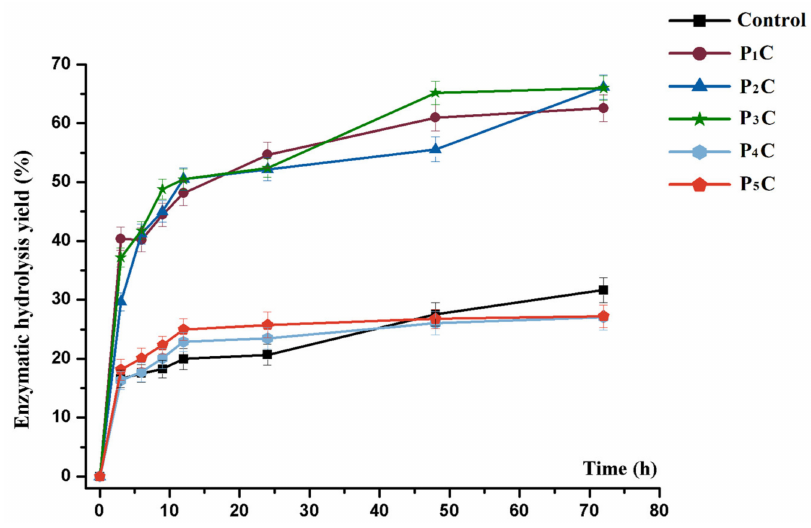
Figure 4. Effect of pretreatment conditions on enzymatic hydrolysis of the fractionated cellulosic